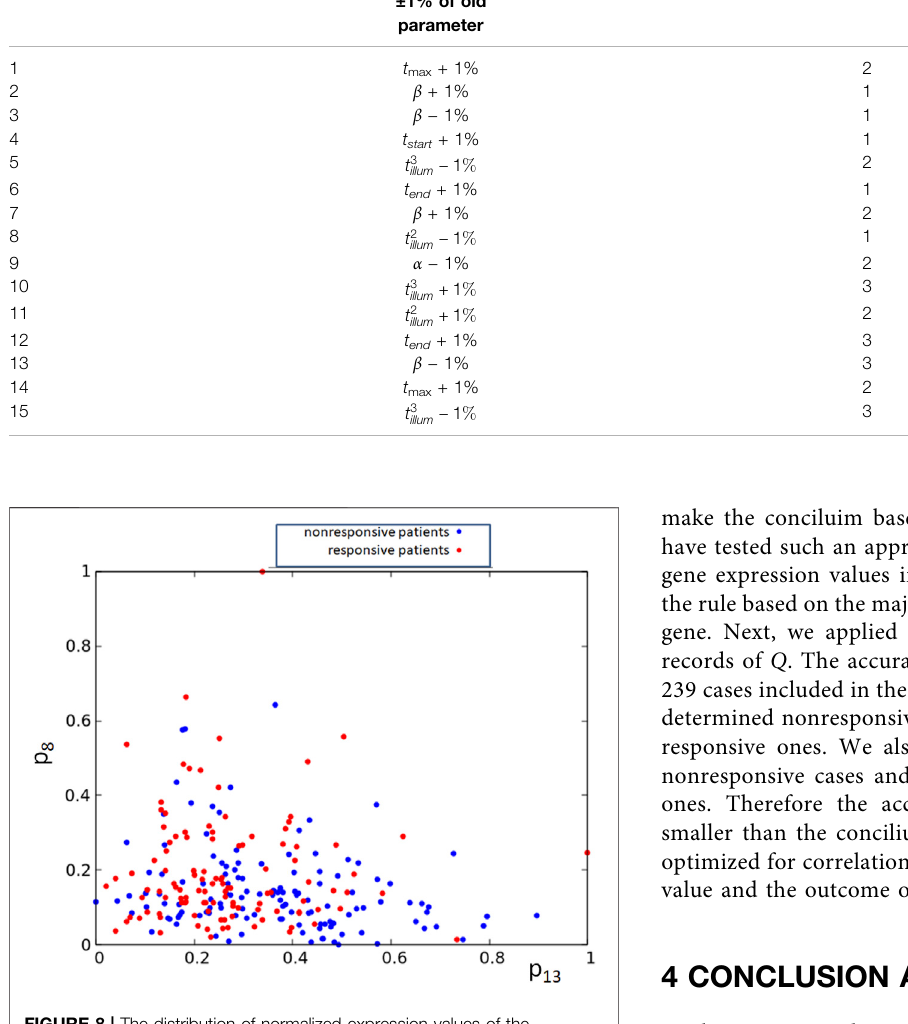
FIGURE 8 | The distribution of normalized expression values of the RPS7 and CFLAR genes corresponding to responsive (red) and nonresponsive (blue) results of drug therapy respectively. The point coordinates are ( p 13, k , p 8, k ), k = 1, 239.